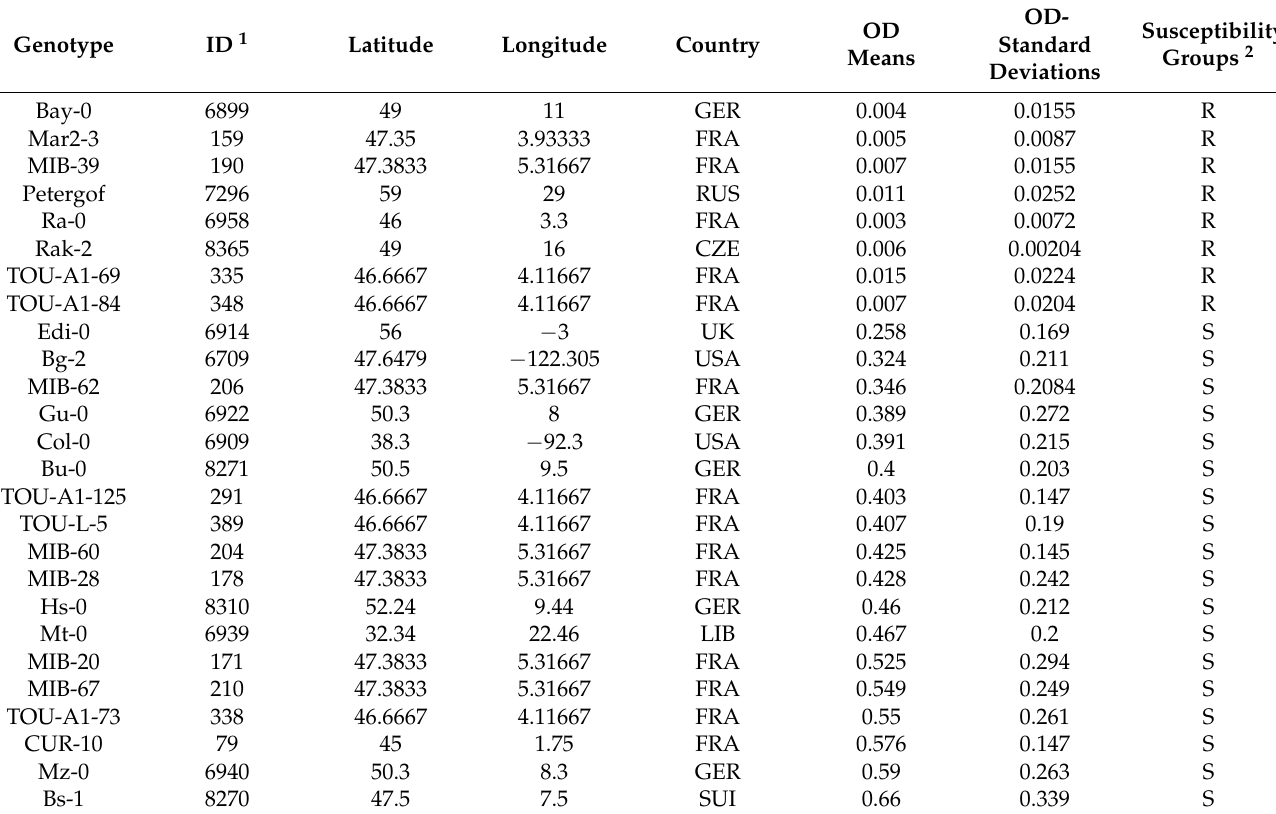
Table 1. List of the A. thaliana accessions with their geographic position and their susceptible status to TuMV infection at 13 dai confirmed by OD values and its SD in the 2015 field experiment.